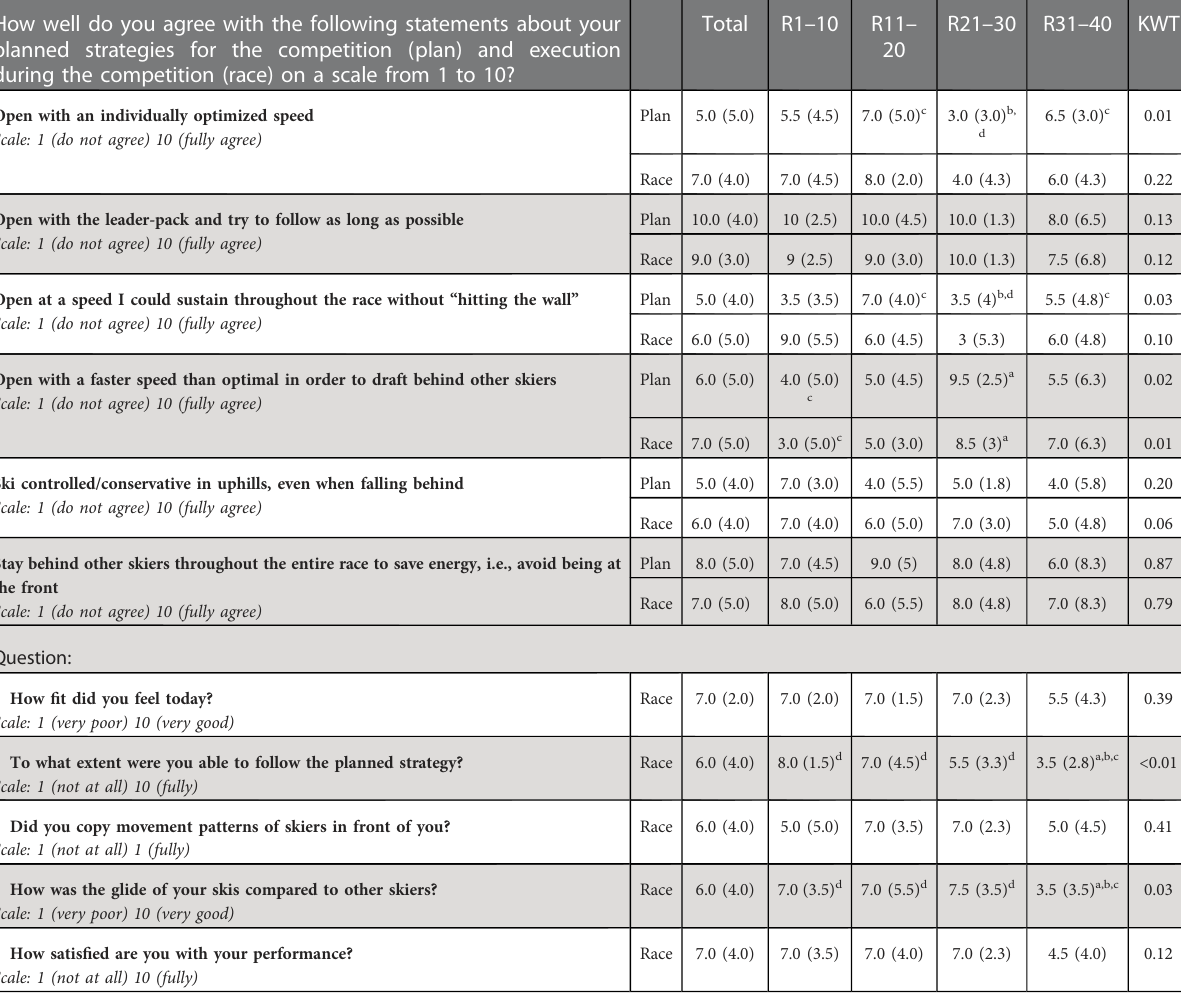
fl at terrain; and 26.9%, 13.6%, and 23.8% going downhill, all respectively. Final sprint When approaching the fi nal km, the leader pack consisted of 10 skiers, and the outcome of the competition was decided in a fi nal sprint. All top 10 skiers were within 19 s of each other, the top 5 skiers were within 2.4 s of each other, and a photo fi nish differentiated fi rst from second place. Figure 9 illustrates each skier ’ s time behind the winner during the fi nal 1.2 km of the race (left) and the fi rst two skiers crossing the fi nish line (right).